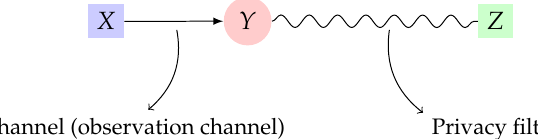
Figure 1. Information-theoretic